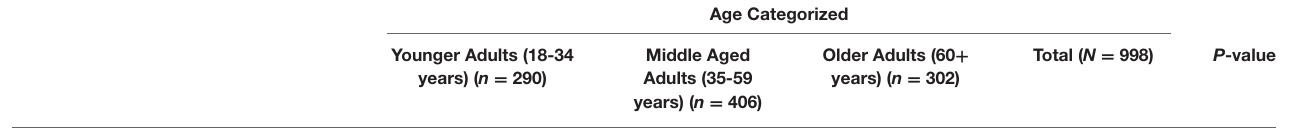
TABLE 3 | Treatment preference stratified by age